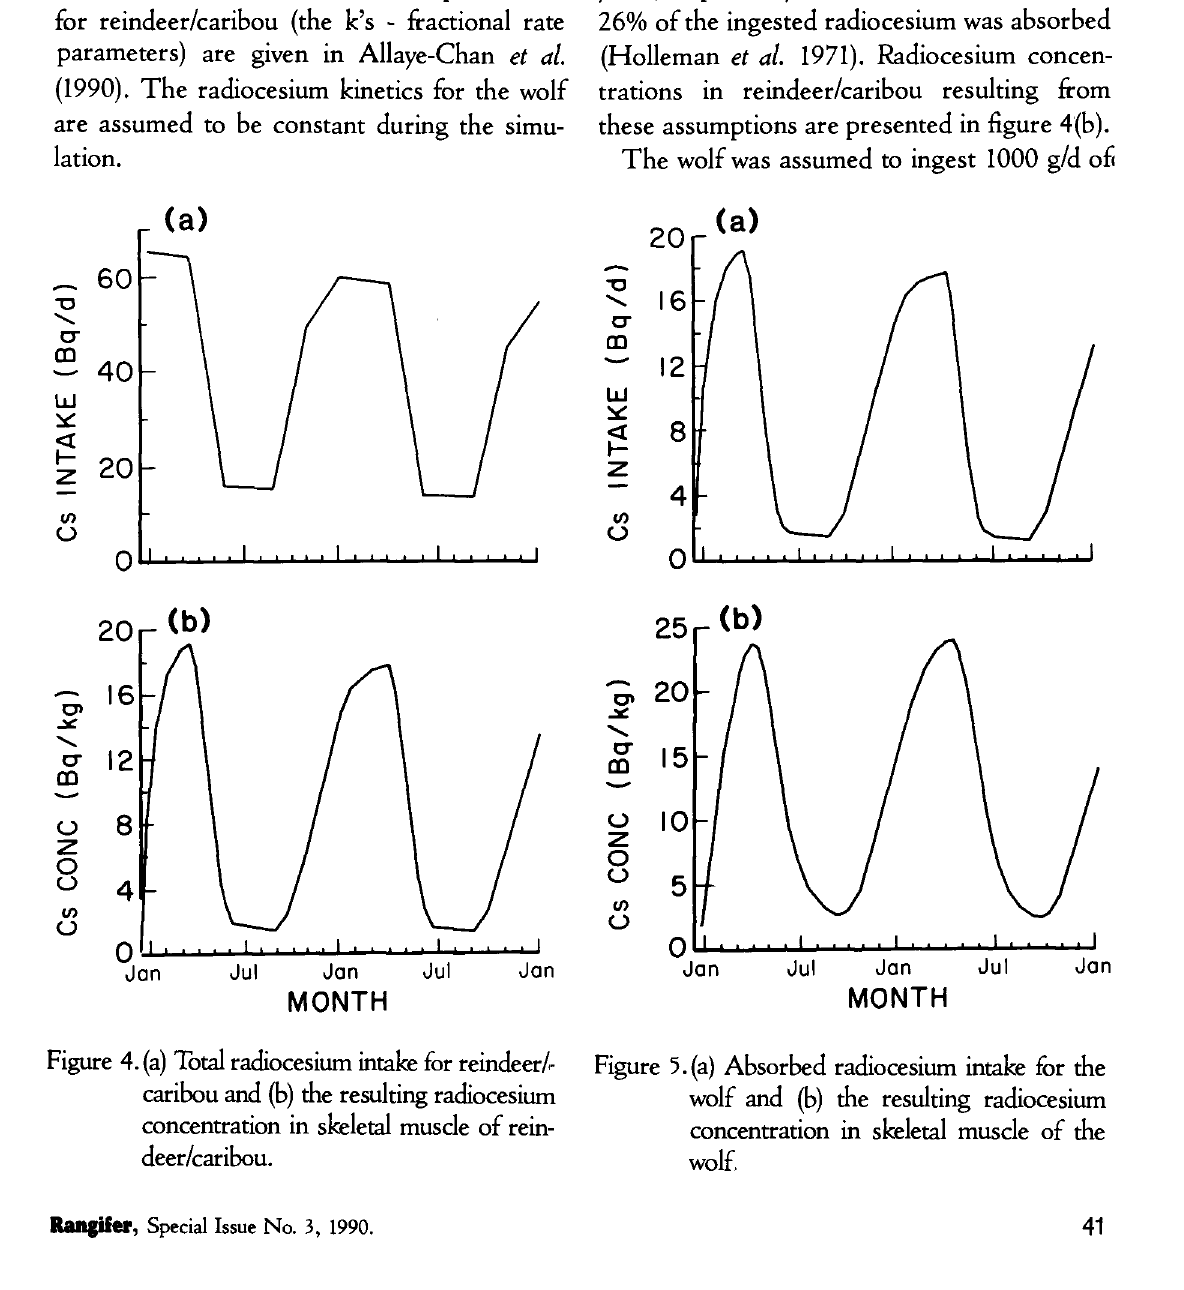
Figure 5.(a) Absorbed radiocesium intake for the wolf and (b) the resulting radiocesium concentration in skeletal muscle of the